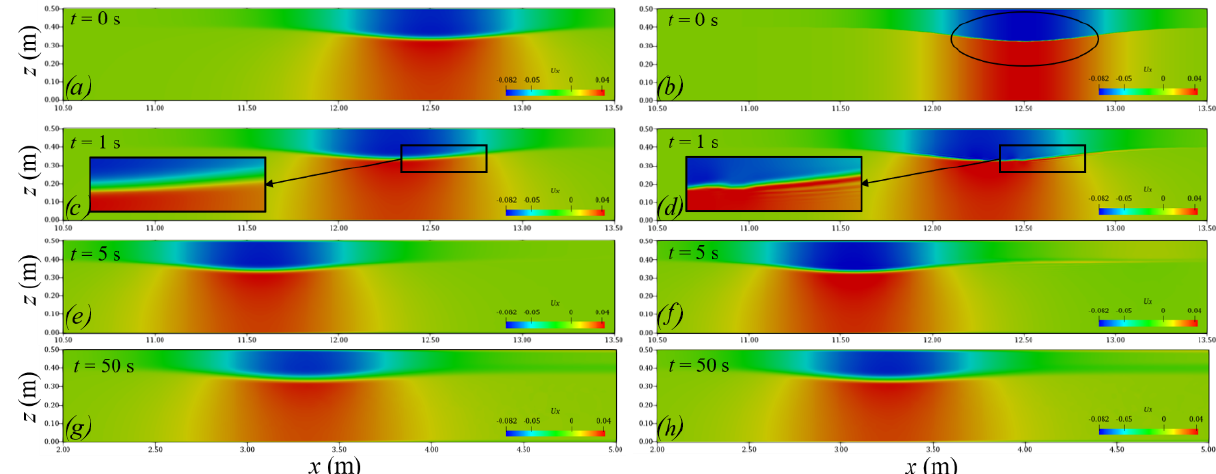
Figure 1. Comparison chart of the horizontal velocity component field: DJL equation (left) and eKdV equation (right).